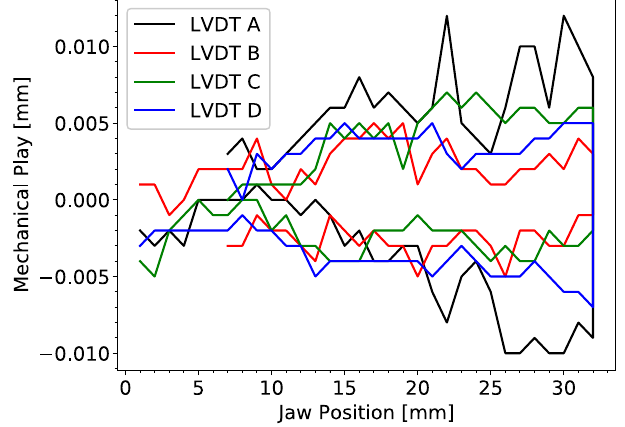
FIG. 6. Residual LVDT readings for the four collimator axes, subtracted from the absolute position, for a full-in/full-out jaw movement, indicating mechanical plays of at most 20 μ m over a 30 mm stroke.